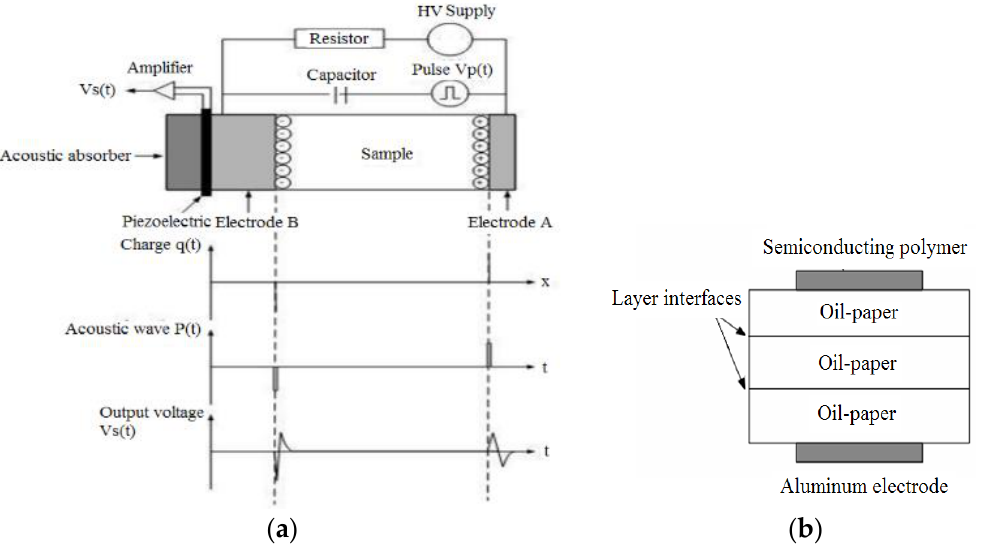
Figure 1. Pulsed electroacoustic (PEA) measurement principle and the measured sample. ( a ) PEA method principle; ( b ) sample arrangement.